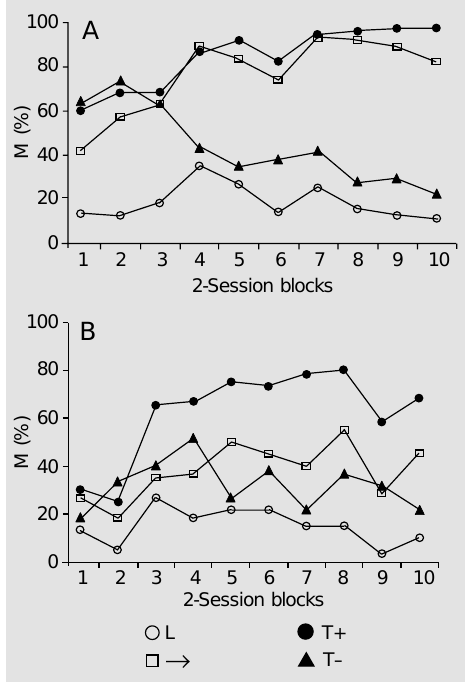
Figure 1. Magazine sniffing/lick- ing behavior (M) during periods of serial compound trials [feature fi (L); empty interval ( ); target fol- lowed by reinforcement (T+)], and during tone-alone trials (T-), for Wistar rat (A) and hamster (B) groups in 2-session blocks of dis- crimination training. Data are re- ported as means in